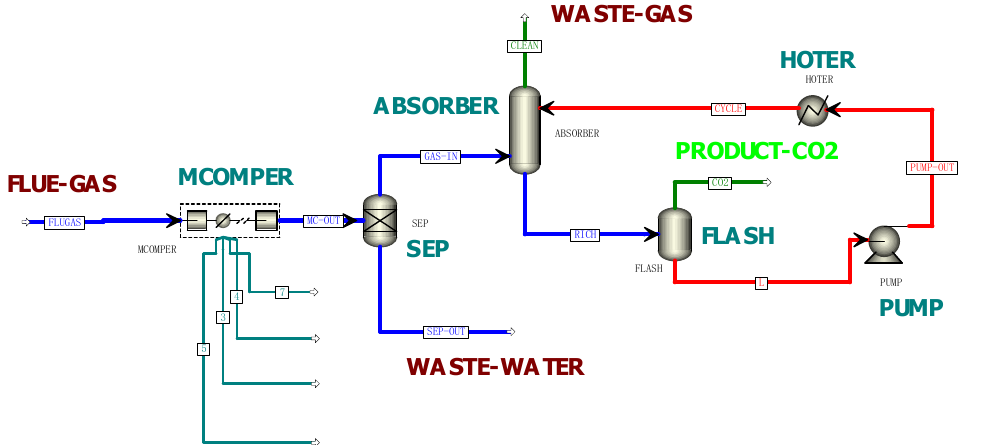
Figure 1. Process flow diagram for CO 2 capture using [emim][Tf 2 N].